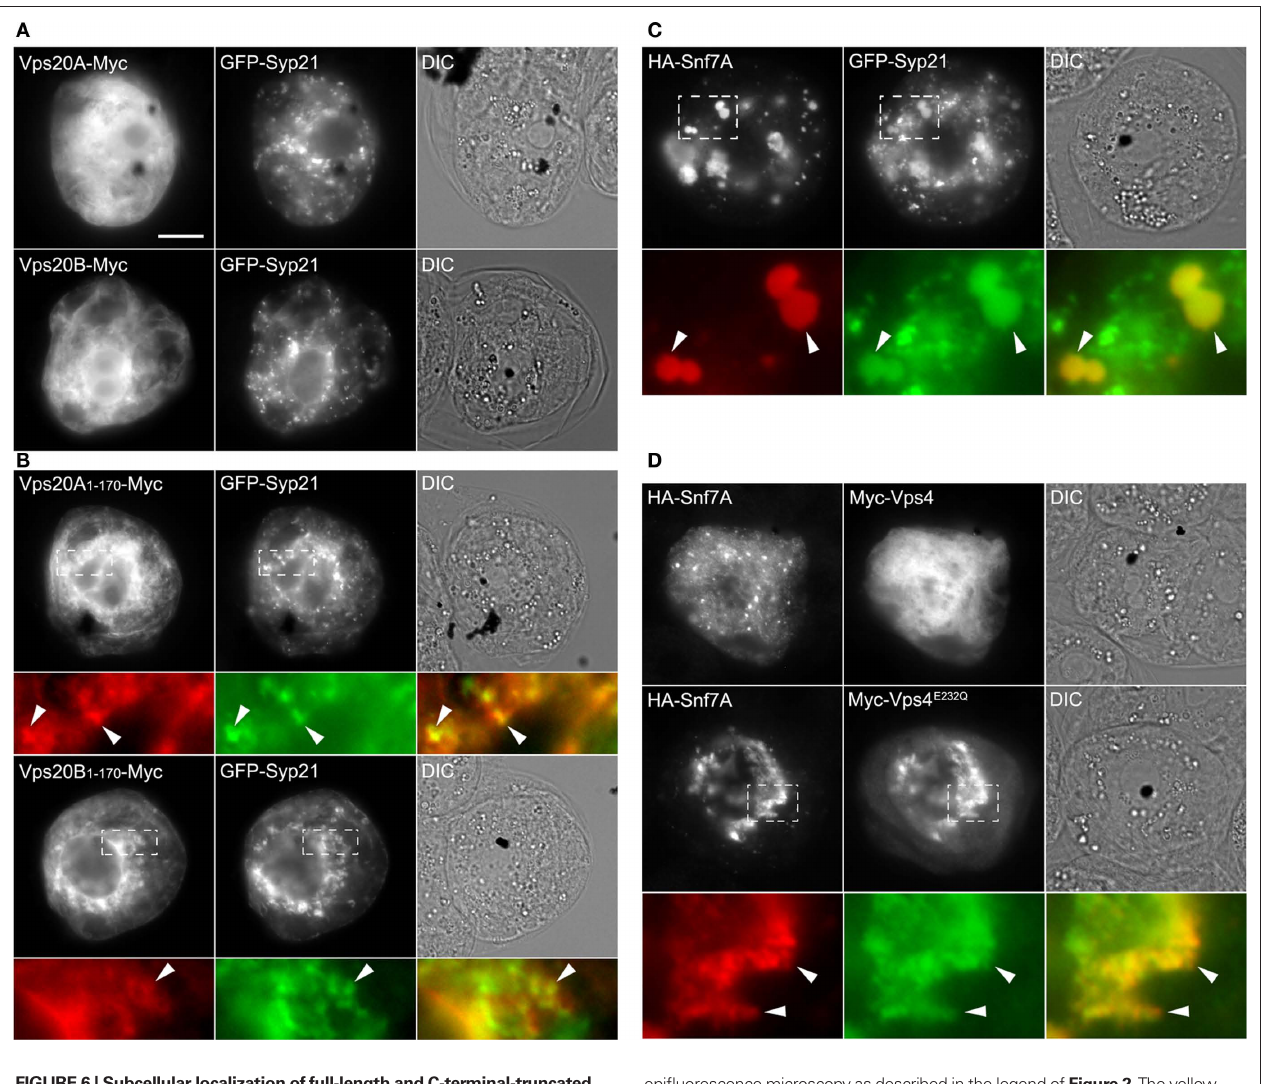
epifluorescence microscopy as described in the legend of Figure 2 . The yellow color in the corresponding merged images [in (B–D) ] indicates co‑localization, between co‑expressed proteins; white arrowheads indicate obvious protein co‑localization including in the enlarged globular‑like structures in (C) . Bar =